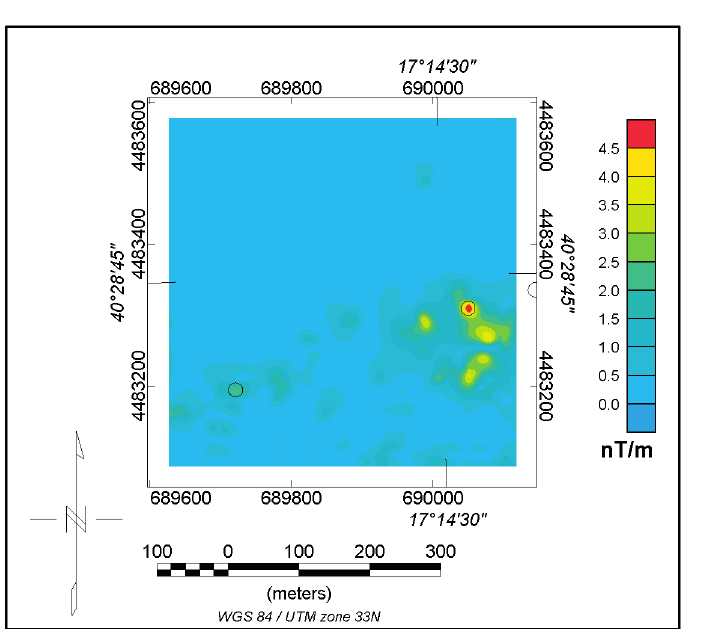
Fig. 4. 3D magnetic analytic signal norm calculated in the boxed area of fig. 2 using gradiometric